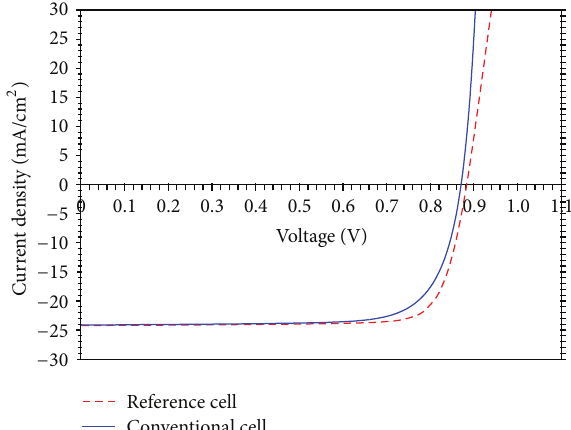
Figure 2: Comparison between the photocurrent density-voltage ( 𝐽 - 𝑉 ) curves for a conventional cell (blue line) and a reference cell (red